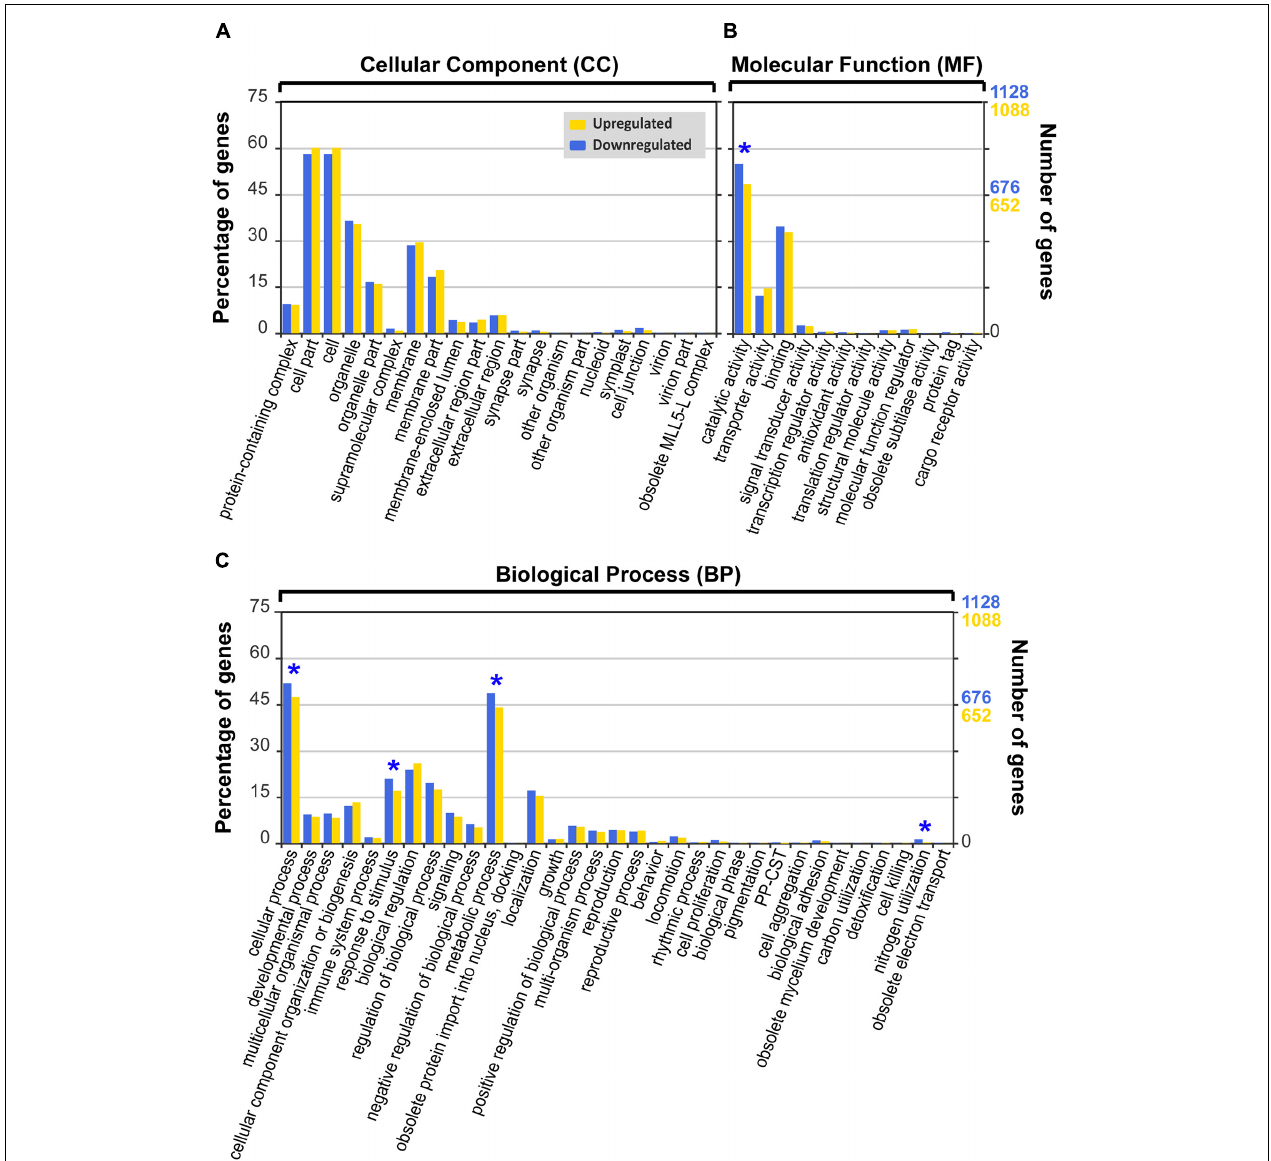
FIGURE 6 | Gene Ontology (GO) functional classification (level 2) of differentially expressed genes (DEGs) of Biecheleriopsis adriatica under heat stress against optimal temperature. Category: (A) cellular component, (B) molecular function, and (C) biological process. The GO subcategories with significantly more downregulated genes than upregulated genes ( p < 0.05, Pearson’s chi-squared test) are marked as blue asterisks. PP-CST: presynaptic process involved in chemical synaptic